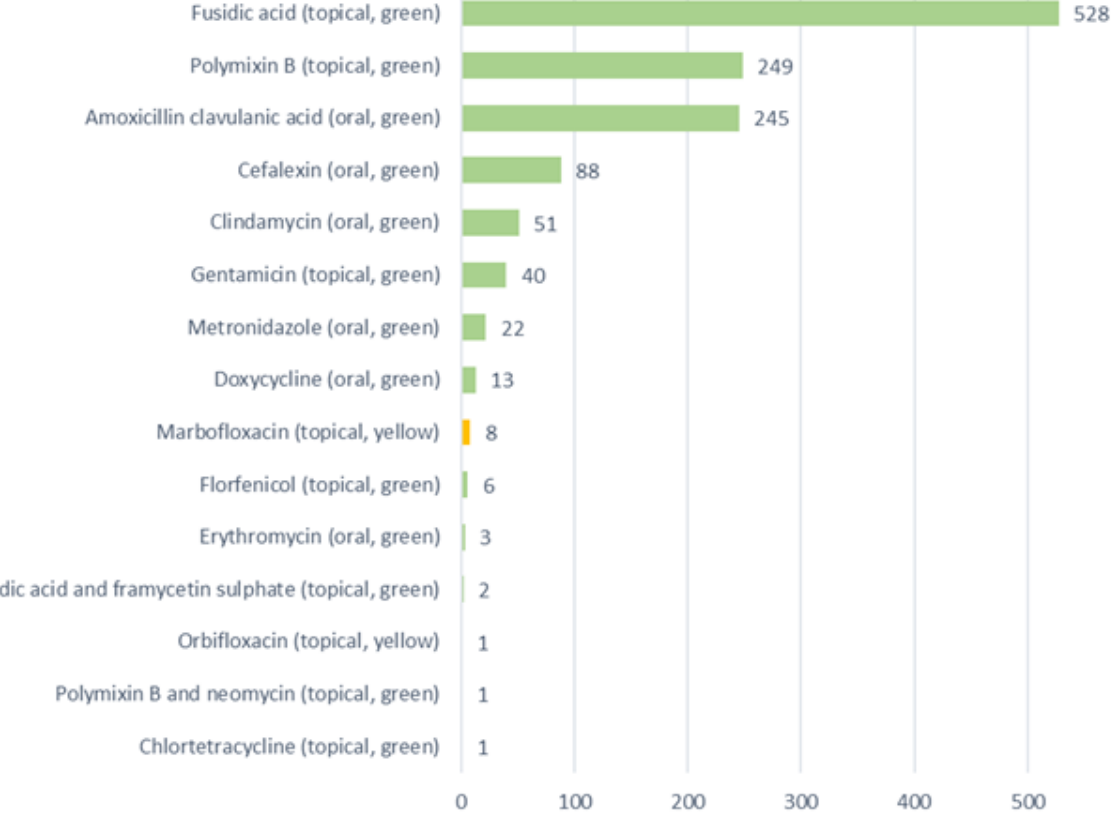
Figure 3: Antibacterial POM-V / POM medications prescribed remotely during the audit period A bar chart depicting the antibacterials prescribed as a result of completed remote veterinary led video consultations via a dedicated veterinary telemedicine smartphone app. between 1 April – 31 October 2020, and the application route (topical or oral). (Green = first line antibacterials, yellow = highest priority critically important antibacterials, red = antibacterials with restricted use in human medicine [none prescribed]). Co-prescribing of